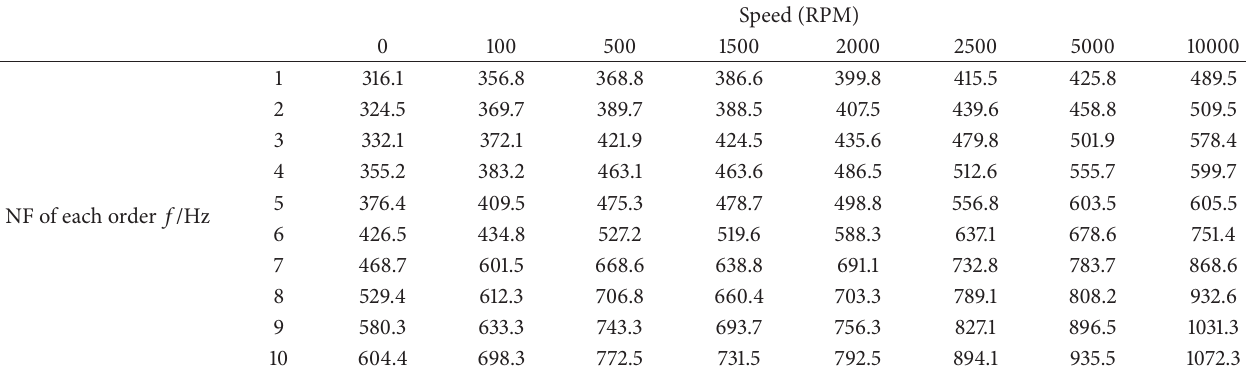
Table 1: NF of the rotating system at different rotating